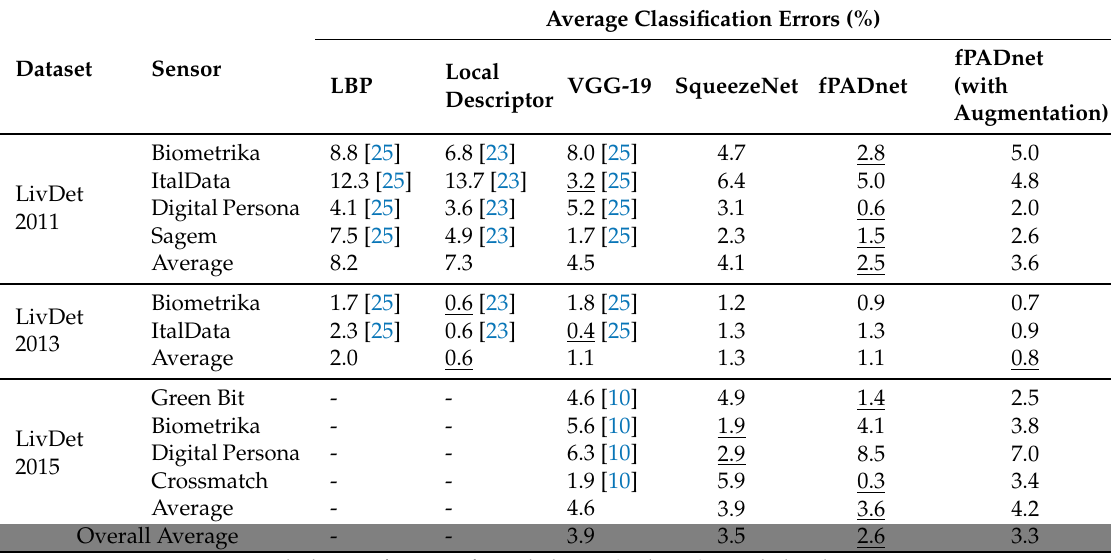
Table 5. Performance comparison on Average Classification Error (ACE). LBP, Local Binary Pattern.